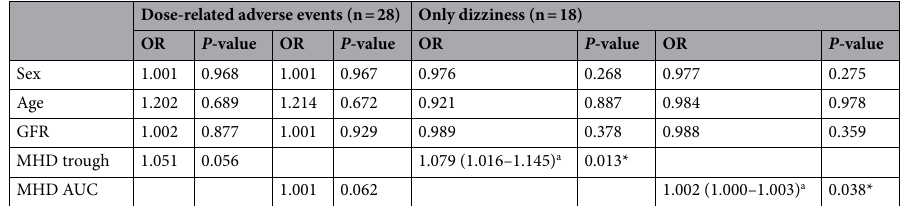
Table 3. Multivariable analysis adjusted for age, sex, and GFR. GFR glomerular filtration rate, MHD Monohydroxy derivative of oxcarbazepine, AUC area under the plasma concentration–time curve. * P < 0.050. a 95% confidence